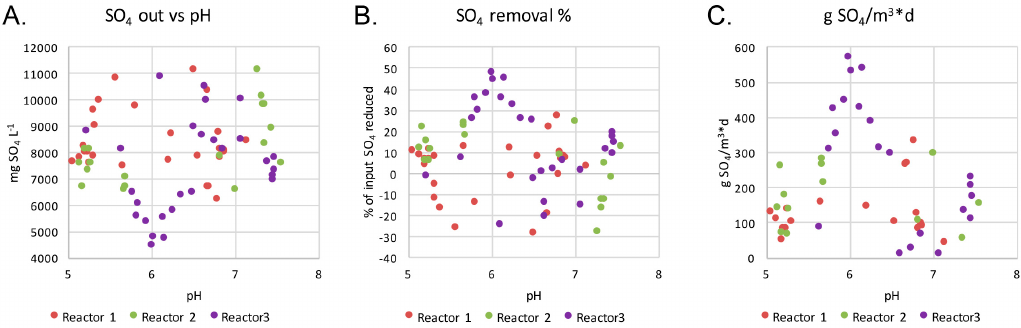
Figure 2. ( A ) The concentration of sulfate (mg L − 1 ), ( B ) the percent of input sulfate removed and ( C ) the total amount of sulfate (g) removed per m 3 of treated water per day plotted against the measured pH of the efflux of the reactors.